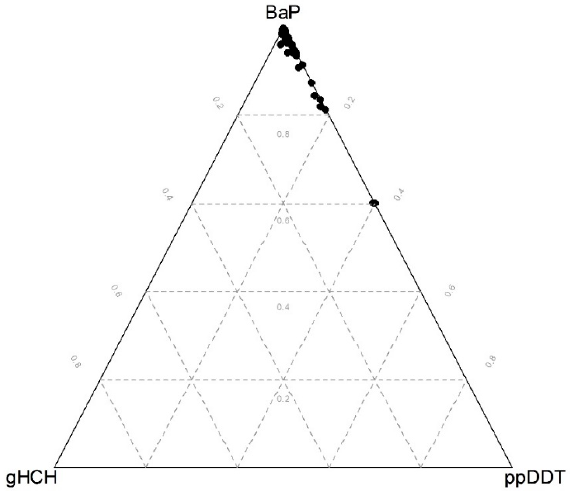
Figure 3. Ternary diagrams of the subcomposition (BaP, gHCH, ppDDT) using raw data components. The membership probabilities from the FCM approach are graphically shown for each